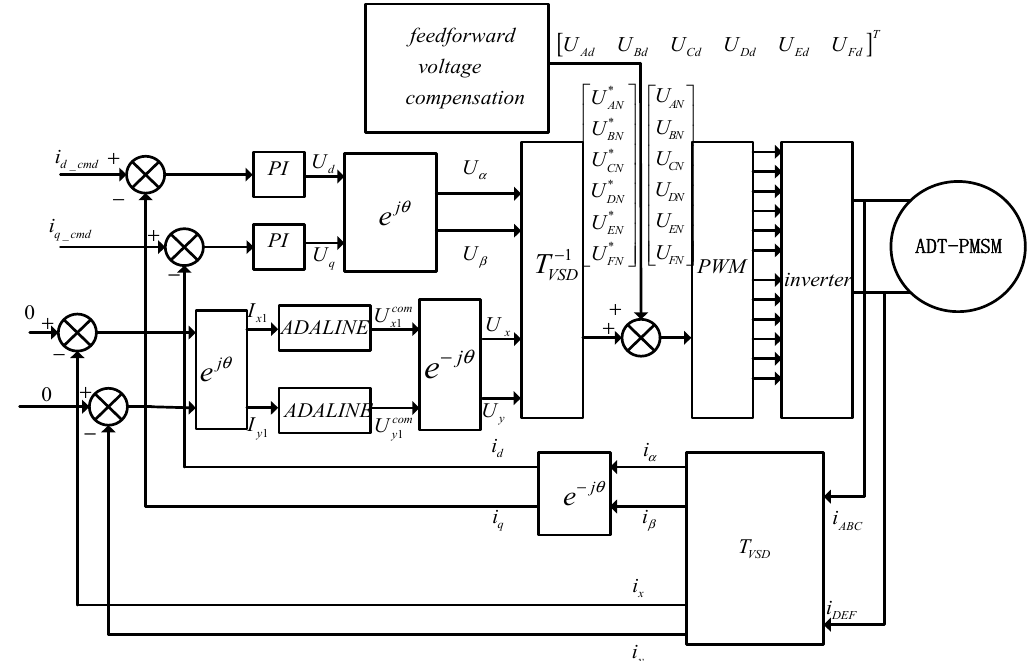
Figure 10. Diagram of control algorithm for asymmetric dual three-phase permanent magnet synchronous motor (ADT-PMSM)